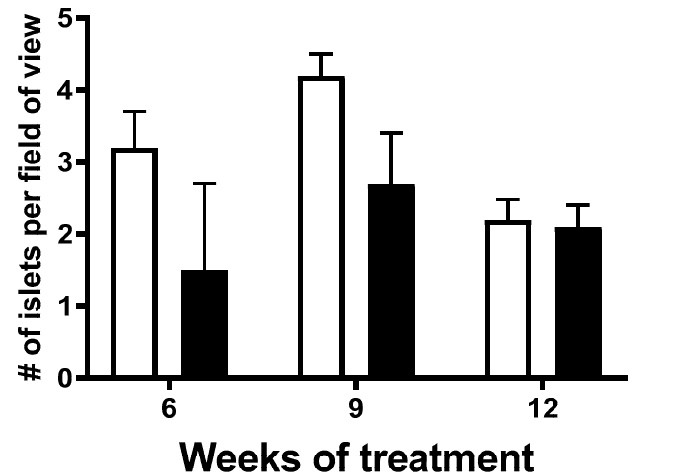
Figure 8. Pancreatic islet density was quantified from H&E stained tissue collected from control- and Cd-treated animals after 6, 9, and 12 weeks of dosing (0.6 mg/kg/day, five days per week, for Cd and equal volumes of saline for control s.c.). 2-way ANOVA showed significant differences when comparing islet density from control vs. Cd-treated animals ( p = 0.0154). No significant differences were found following post-hoc Tukey’s multiple comparison test ( p > 0.05 for all week matched comparisons). Two to three images were captured per tissue section, islet number quantified and averaged; n = 3–6 for each treatment group at each time point.